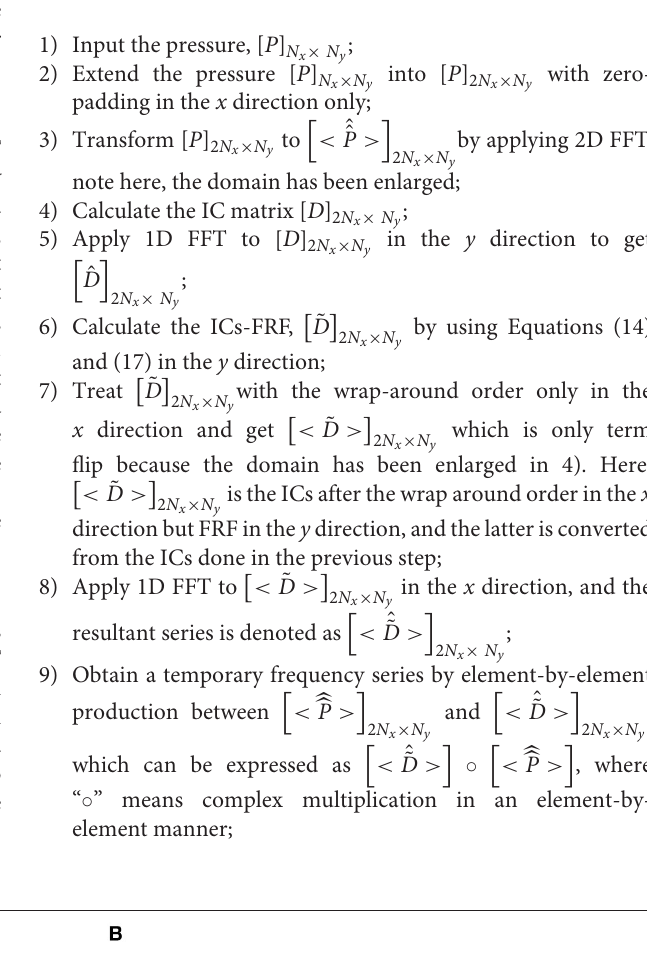
Frontiers in Mechanical Engineering |